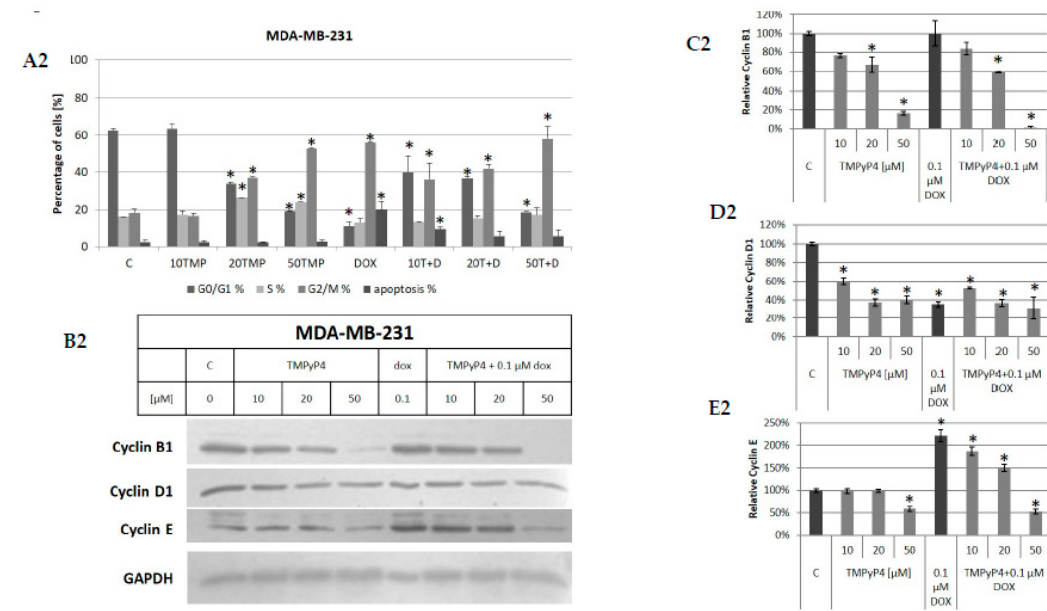
Figure 5. The contribution of TMPyP4 to cell-cycle modification. MCF7 (5.1) and MDA-MB-231 (5.2) were subjected to flow cytometry assessment ( A ), followed by immunodetection of cell cycle associated proteins ( B ) and densitometry analysis of the blots i.e. Cyclin B1 ( C ), Cyclin D1 ( D ), Cyclin E ( E ), respectively. Both studied cell lines were subjected to the analysis of cell cycle after treatment with 10, 20, 50 µ M TMPyP4, 0.1 µ M DOX or a combination of both compounds for 72 h since no significant e ff ects were revealed in shorter time interval neither in MTT nor in a clonogenic assay. Detection of cell-cycle phase was performed in MCF7 (5.1) and MDA-MB-231 cells (5.2) using propidium iodide staining and flow cytometry. Immunodetection of cyclins B1, D1, and E after 72 h treatment with TMPyP4 (0, 10, 20 or 50 µ M), DOX (0.1 µ M) or a combination of these compounds was performed using western blot in MCF7 (5 B1 ) as well as MDA-MB-231 cells (5 B2 ) followed by densitometry analysis (5 C1 , D1 , E1 ,5 C2 , D2 , E2 , respectively). * p < 0.05, relative to control sample. Densitometry analysis was performed out of 3 scanned membranes from 3 independent experiments relative to the loading control, GAPDH.